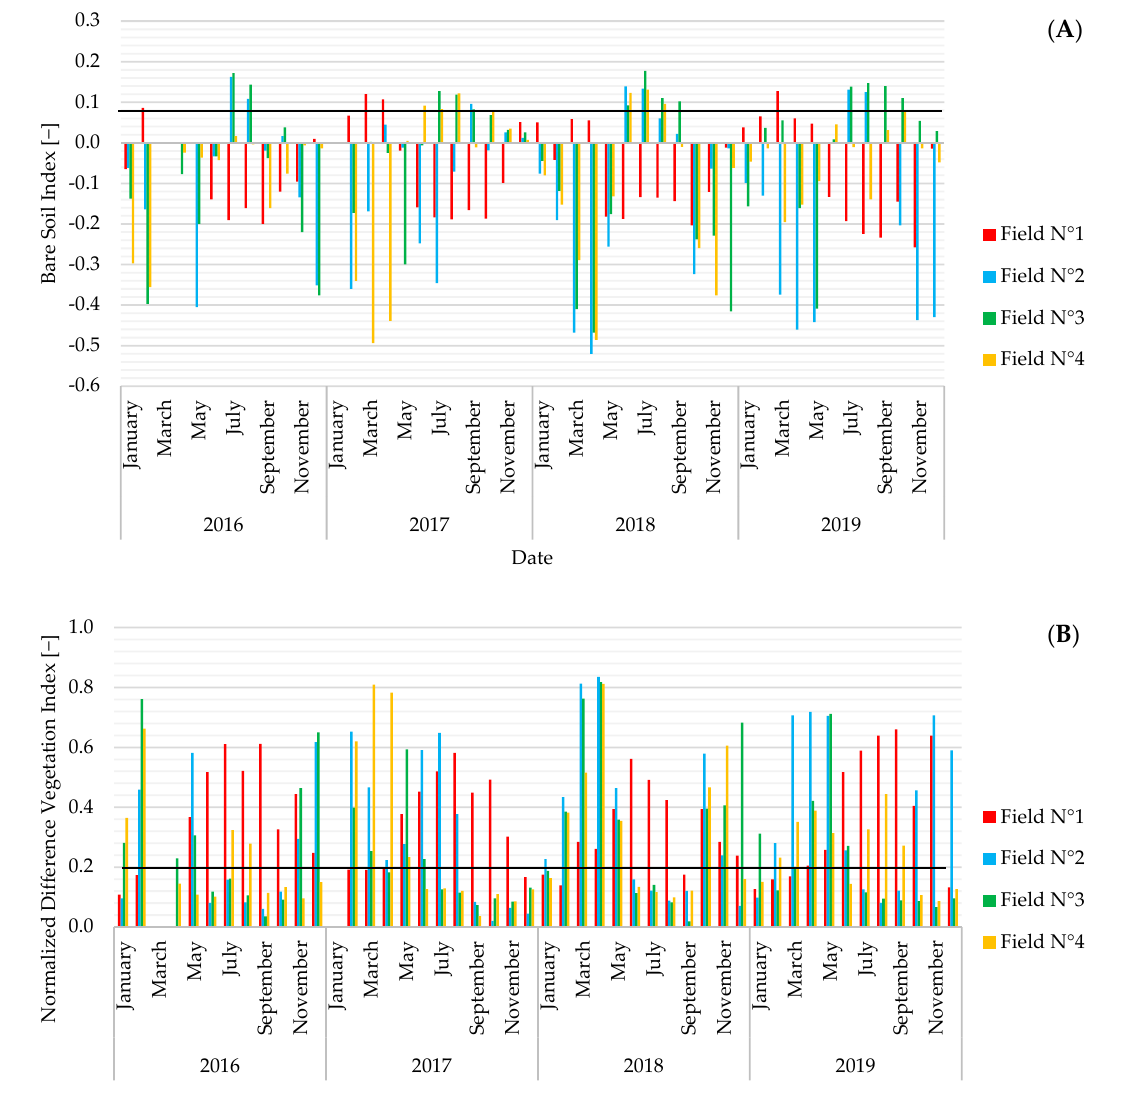
Figure 6. ( A ) Bare Soil Index (BSI) and ( B ) Normalized Difference Vegetation Index values (NDVI) [ − ] for the pixels in the set of selected agricultural fields of the agricultural areas of Capitanata (Southern Italy). The horizontal black lines show the selected thresholds.